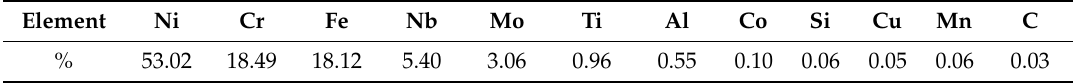
Table 1. Chemical composition of the Inconel 718 (% of wt.) [13].